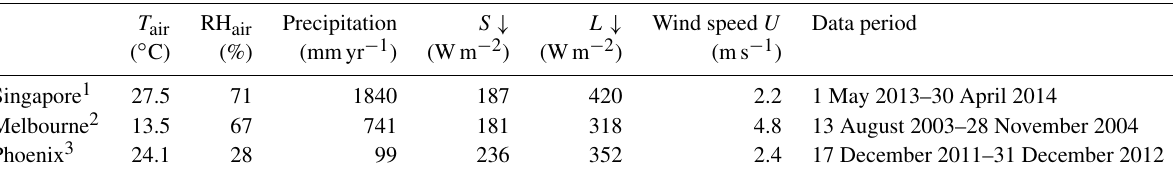
Table 1. Mean values calculated for the entire time period of the meteorological forcing data time series in Telok Kurau in Singapore, Preston in Melbourne, and Maryvale in Phoenix. T air RH air Precipitation S ↓ L ↓ Wind speed U Data period ( ◦ C) (%) (mmyr − 1 ) (Wm − 2 ) (Wm − 2 ) (ms − 1 ) Singapore 1 27.5 71 1840 187 420 2.2 1 May 2013–30 April 2014 Melbourne 2